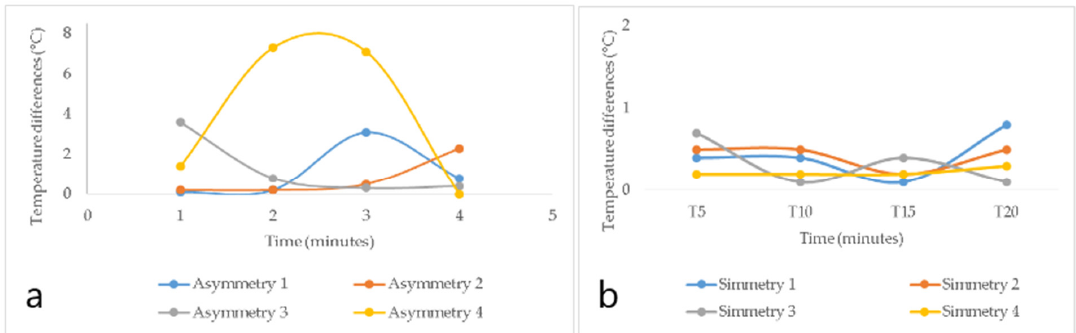
Figure 7. Behavioral graph of minimum temperature differences for the palm of the hand in the subjects of the sanding area. ( a ) corresponds to subjects with asymmetries. ( b ) represents subjects with symmetries.